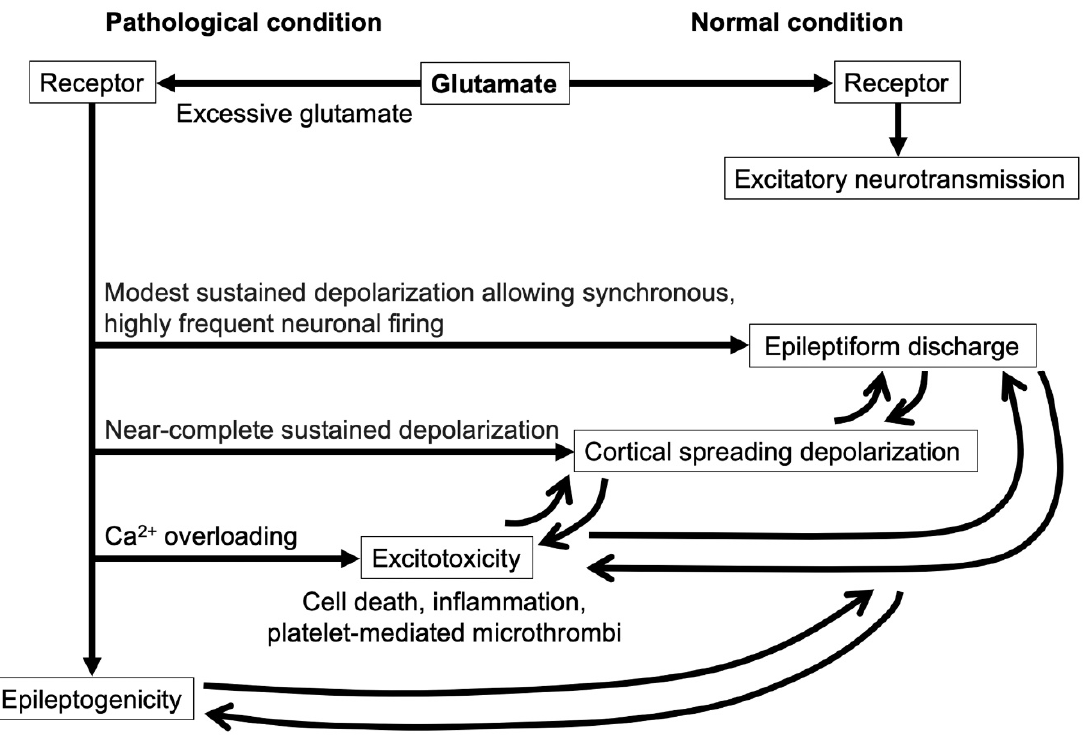
Figure 2. Glutamate action via the receptors. In normal conditions, glutamate is a major excitatory neurotransmitter via the receptor. In pathological conditions, excessive glutamates activate the receptors excessively and cause epileptiform discharges, cortical spreading depolarization, and excitotoxicity, depending on the extent of the cell membrane depolarization. Each of the neuroelectric disruptions triggers the other. Surviving cells irrespective of these events achieve